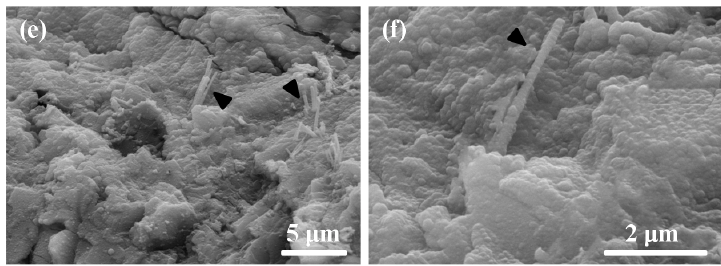
Figure 5. Morphology of ( a ) the initial ZnOw powder and typical fracture surfaces of the scaffolds with ( b ) 0 wt %; ( c ) 3 wt %; ( d ) 5 wt %; ( e ) 10 wt % ZnOw and ( f ) matrix remnants on the ZnOw. The black triangles indicate the ZnOw.